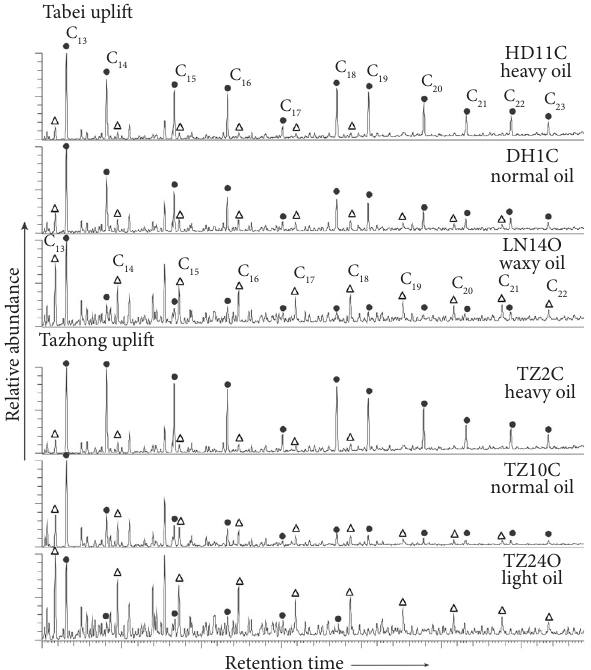
Figure 1: Mass chromatograms ( m/z 133+134) of aromatic fractions of selected oil samples showing AIP and AA distributions. Filled circles indicate AIPs, and un fi lled triangles indicate newly identi fi ed